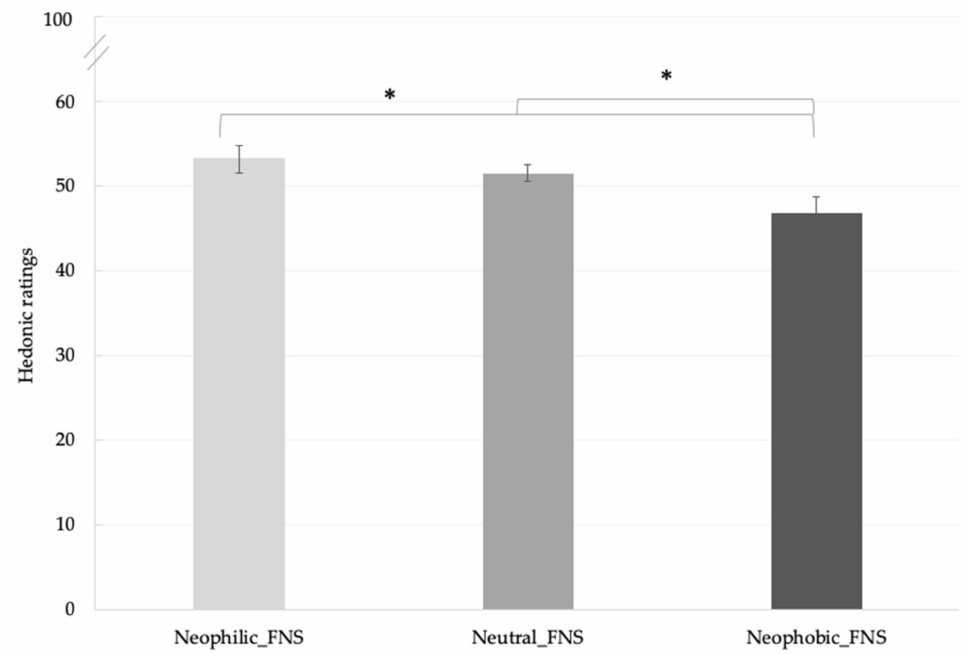
Figure 3. Mean liking scores ± SEM according to food neophobia levels. * p < 0.05. FNS = Food Neophobia